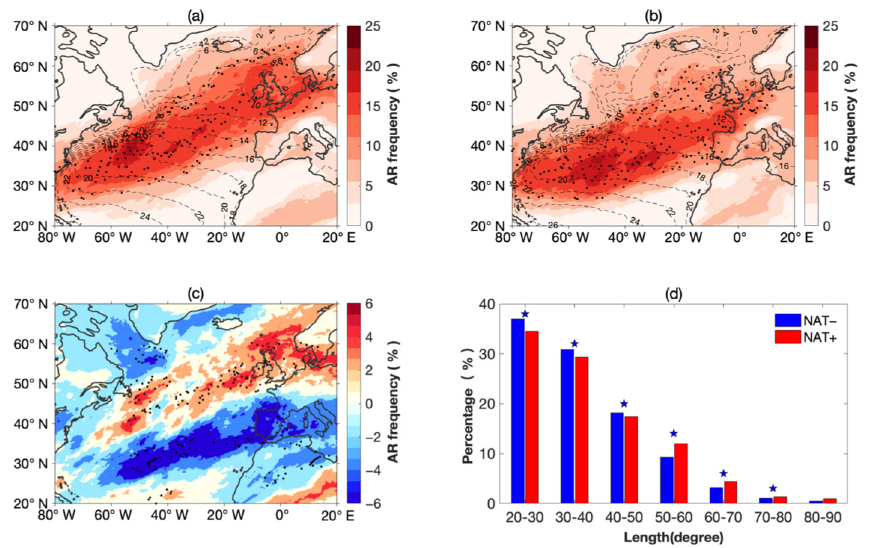
Figure 4. ( a ) AR occurrence frequency (colors, %) and mean SST (contours, °C) in NAT+ phase. ( b ) AR occurrence frequency (colors) and mean SST (contours) in NAT − phase. ( c ) The difference in AR occurrence frequency in NAT+ and NAT − phases (color). Black dots mark those above 95% confidence level based on a Student’s t -test. ( d ) Histogram of the percentage of the length (in degree) of ARs. A difference above 95% confidence level based on a Student’s t -test is marked by the blue stars over the bar.